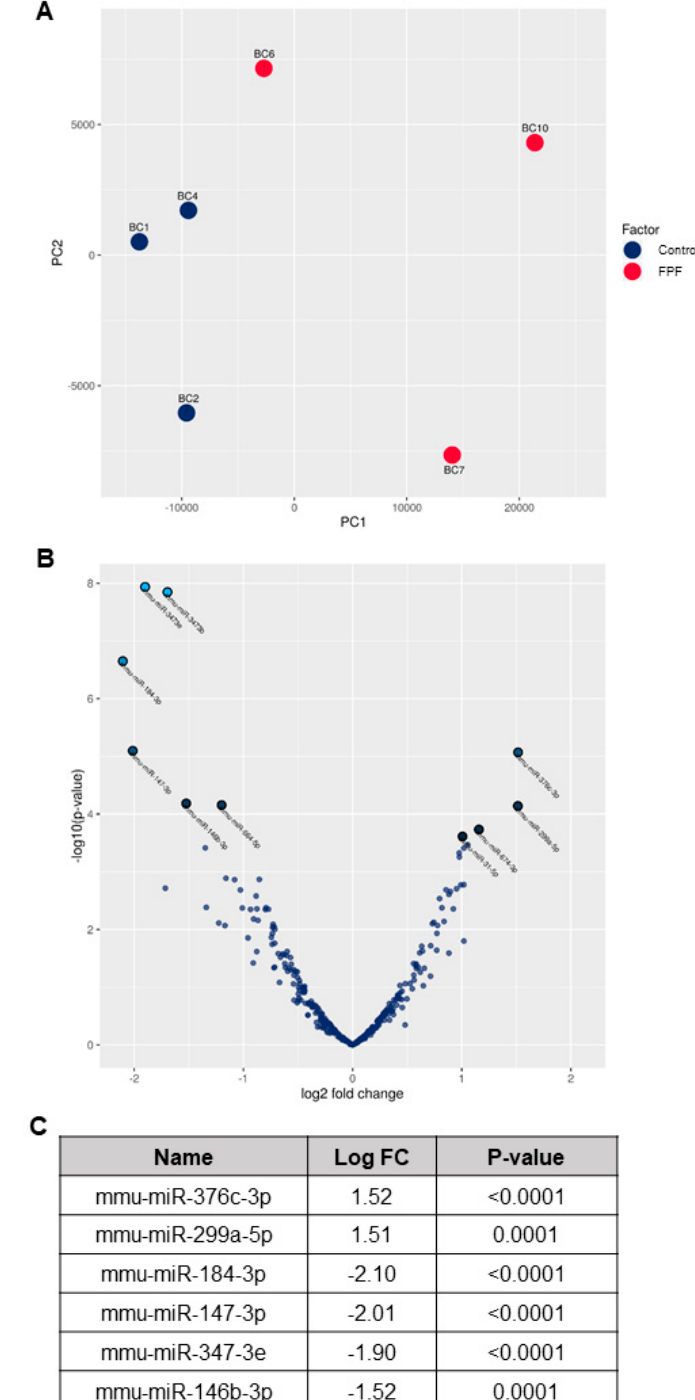
Figure 7. FPF modulates transcriptional regulation of fibrosis. Next Generation Sequencing for miRs was performed on flash-frozen tissue sections prepared from control and FPF-treated mice (n = 3/group). ( A ) Principal component analysis (PCA) showing the distance and relatedness between samples, with 50 miRs having the largest coefficient of variation. ( B ) Volcano plot showing the relationship between p-values and fold change in normalized expression between control and FPF-treated groups. ( C ) Most differentially-expressed known miRs. A complete list of the 25 most significantly differentially-expressed miRs and annotation, with log fold change (logFC) between control and FPF-treated groups is shown in Supplementary Table S1. N = 3 mice/group.